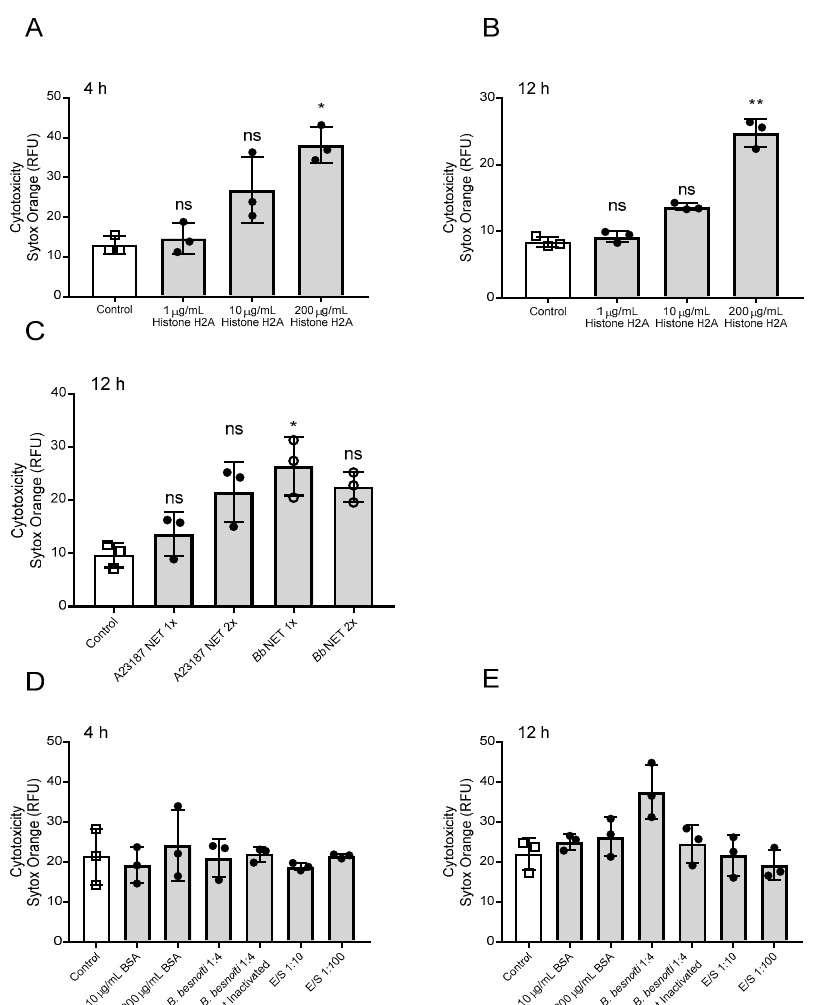
Figure 2. Histone 2A (H2A) and NETs preparations induce cell death in bovine umbilical